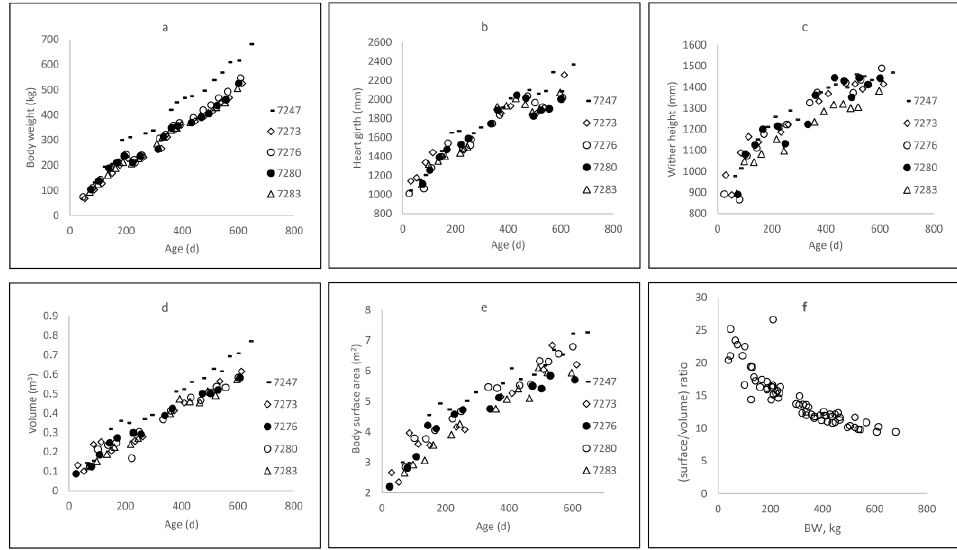
Figure 2. Dynamics of body weight ( a ), heart girth ( b ), wither height ( c ), surface area ( d ), and volume ( e ) as a function of age, and ( f ) surface-to-volume ratio as a function of body weight for five Holstein heifers, from 5 weeks of age until the end of